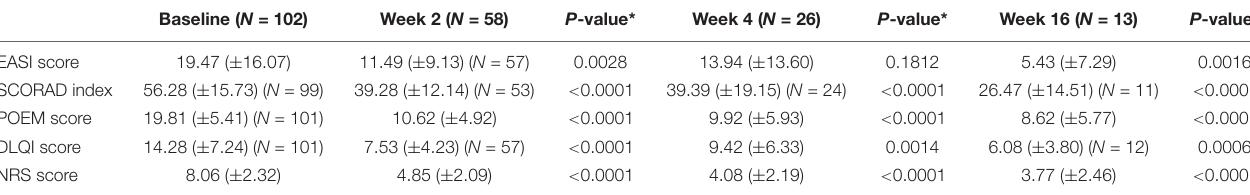
TABLE 3 | Scoring characteristics in patients with AD at baseline and follow-up after 2, 4, and 16